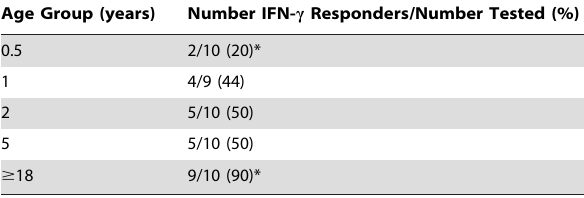
Table 2. Proportion of individuals by age group with IFN- c responses to MSP1 42 -3D7 as detected by ELISPOT.